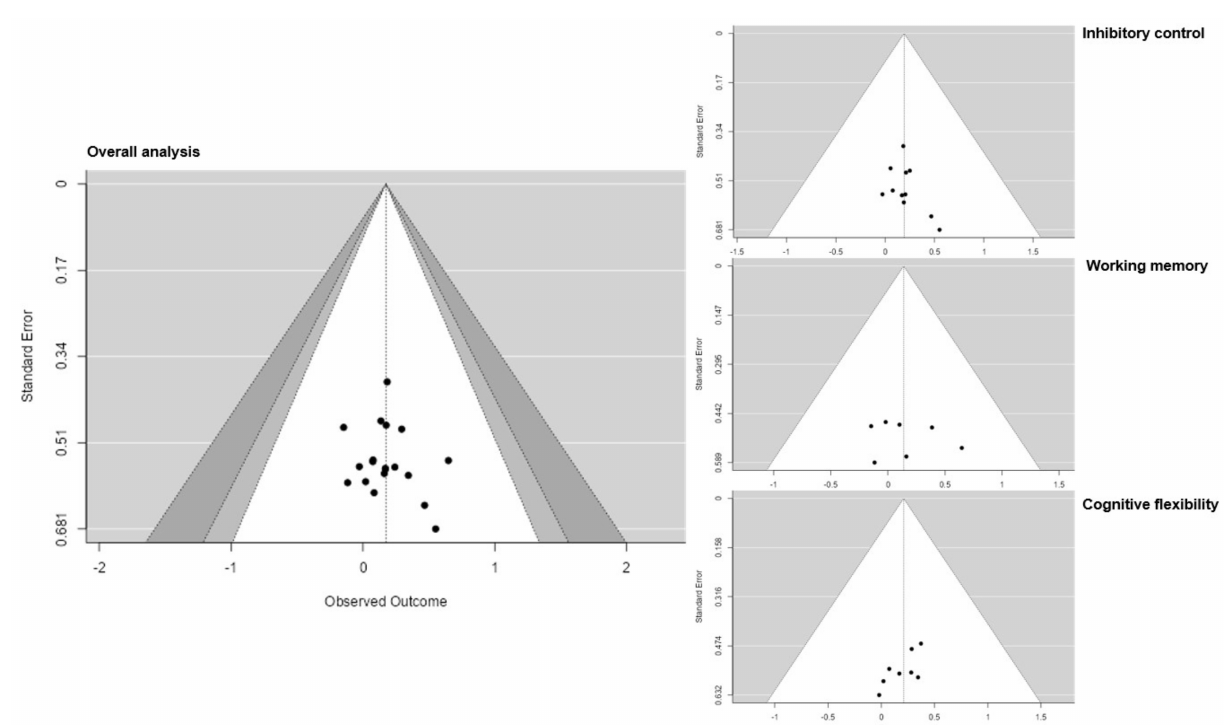
Figure 4. Funnel plots for overall analysis, inhibition, working memory and cognitive